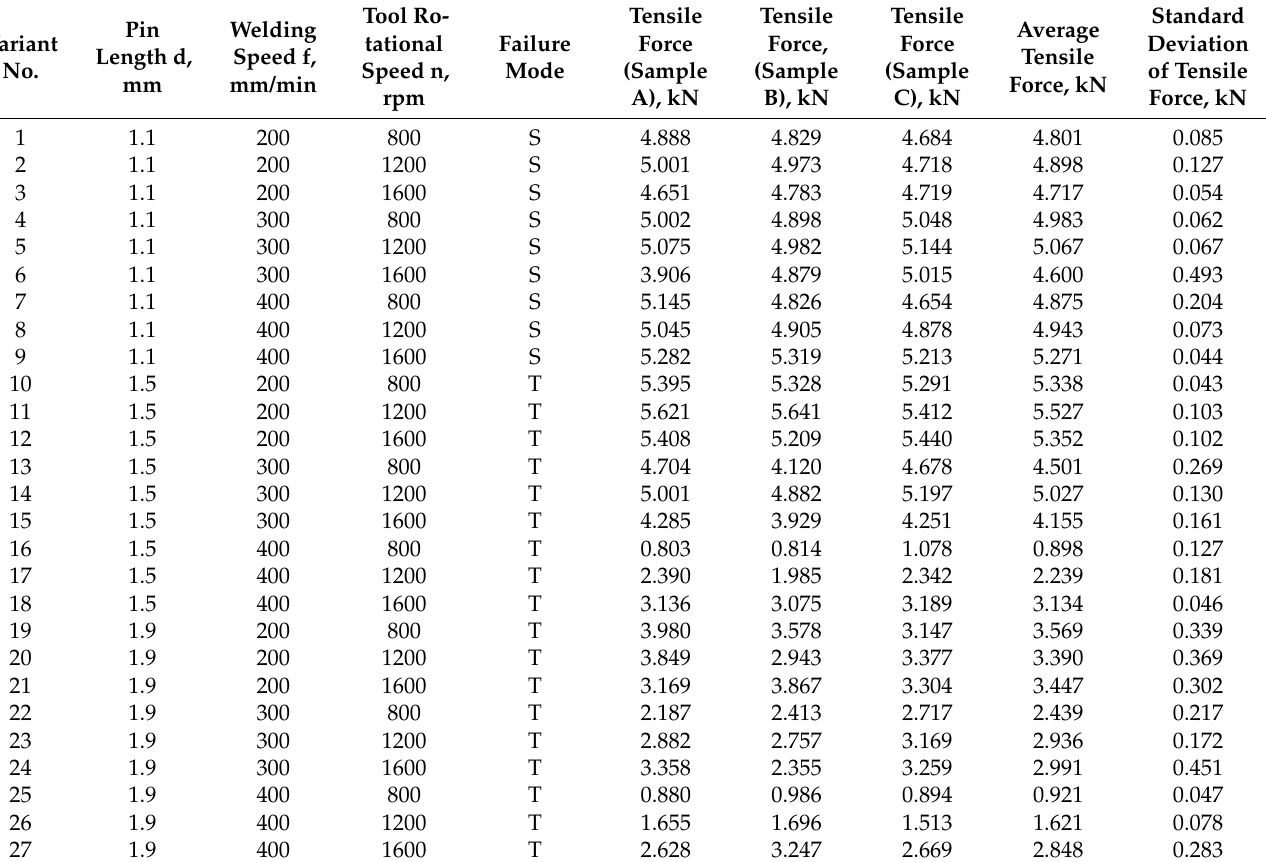
Table 4. Standardised effects of the welding parameters on the tensile strength (S—shear failure mode, T—tensile failure